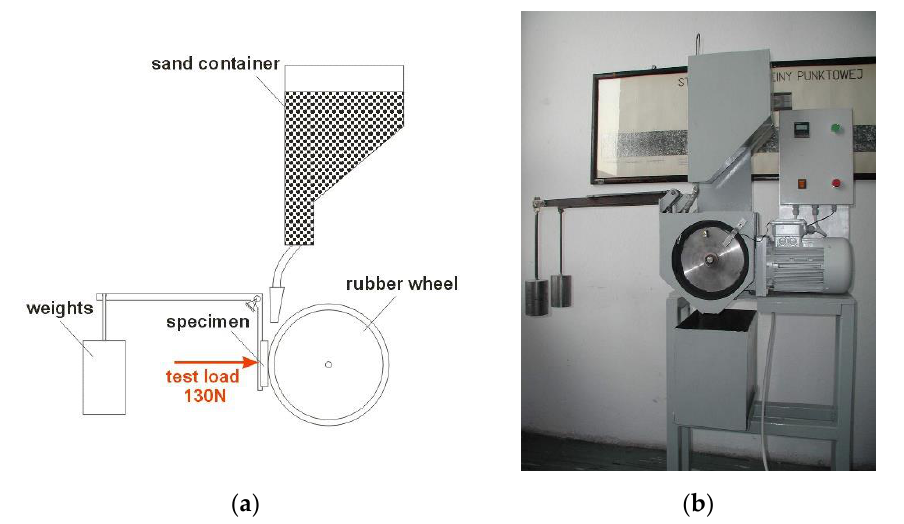
Figure 4. Metal-mineral wear resistance test stand–according to ASTM G65–00, Procedure E standard [43] ( a ) a schematic view, ( b ) picture of the device used .